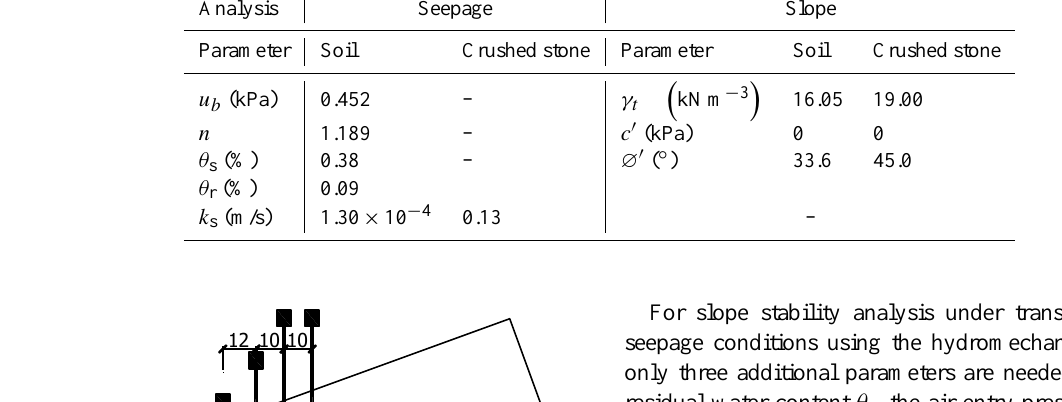
Table 2. Geotechnical and hydraulic properties of model slope. Analysis Seepage Slope Crushed stone